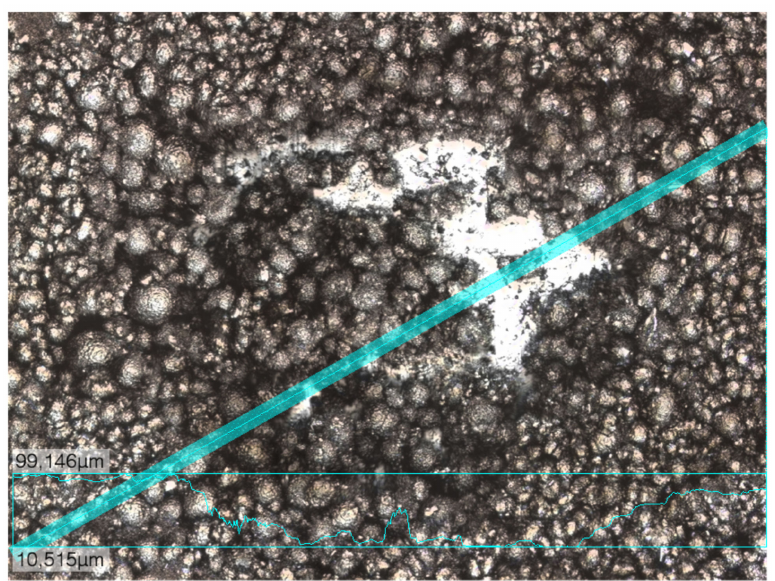
Figure 2. Microscope image of the nearly fully ablated coating. The shiny part shows the aluminum foil. In the central crater, the NMC beads can be seen clearly. Outside of the crater, the NMC is partly covered with graphite and binder.